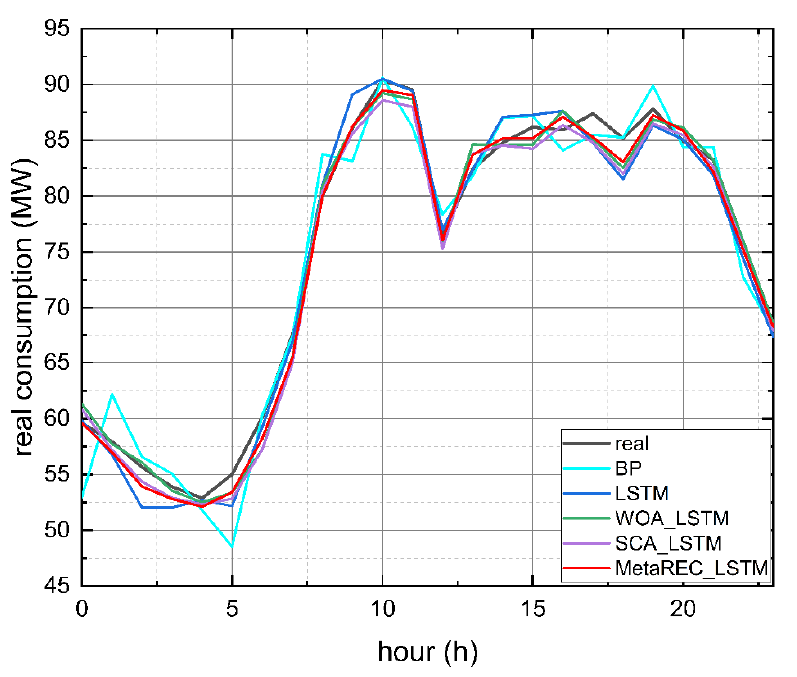
Figure 12. Electric load measurements and predictions made by various models.